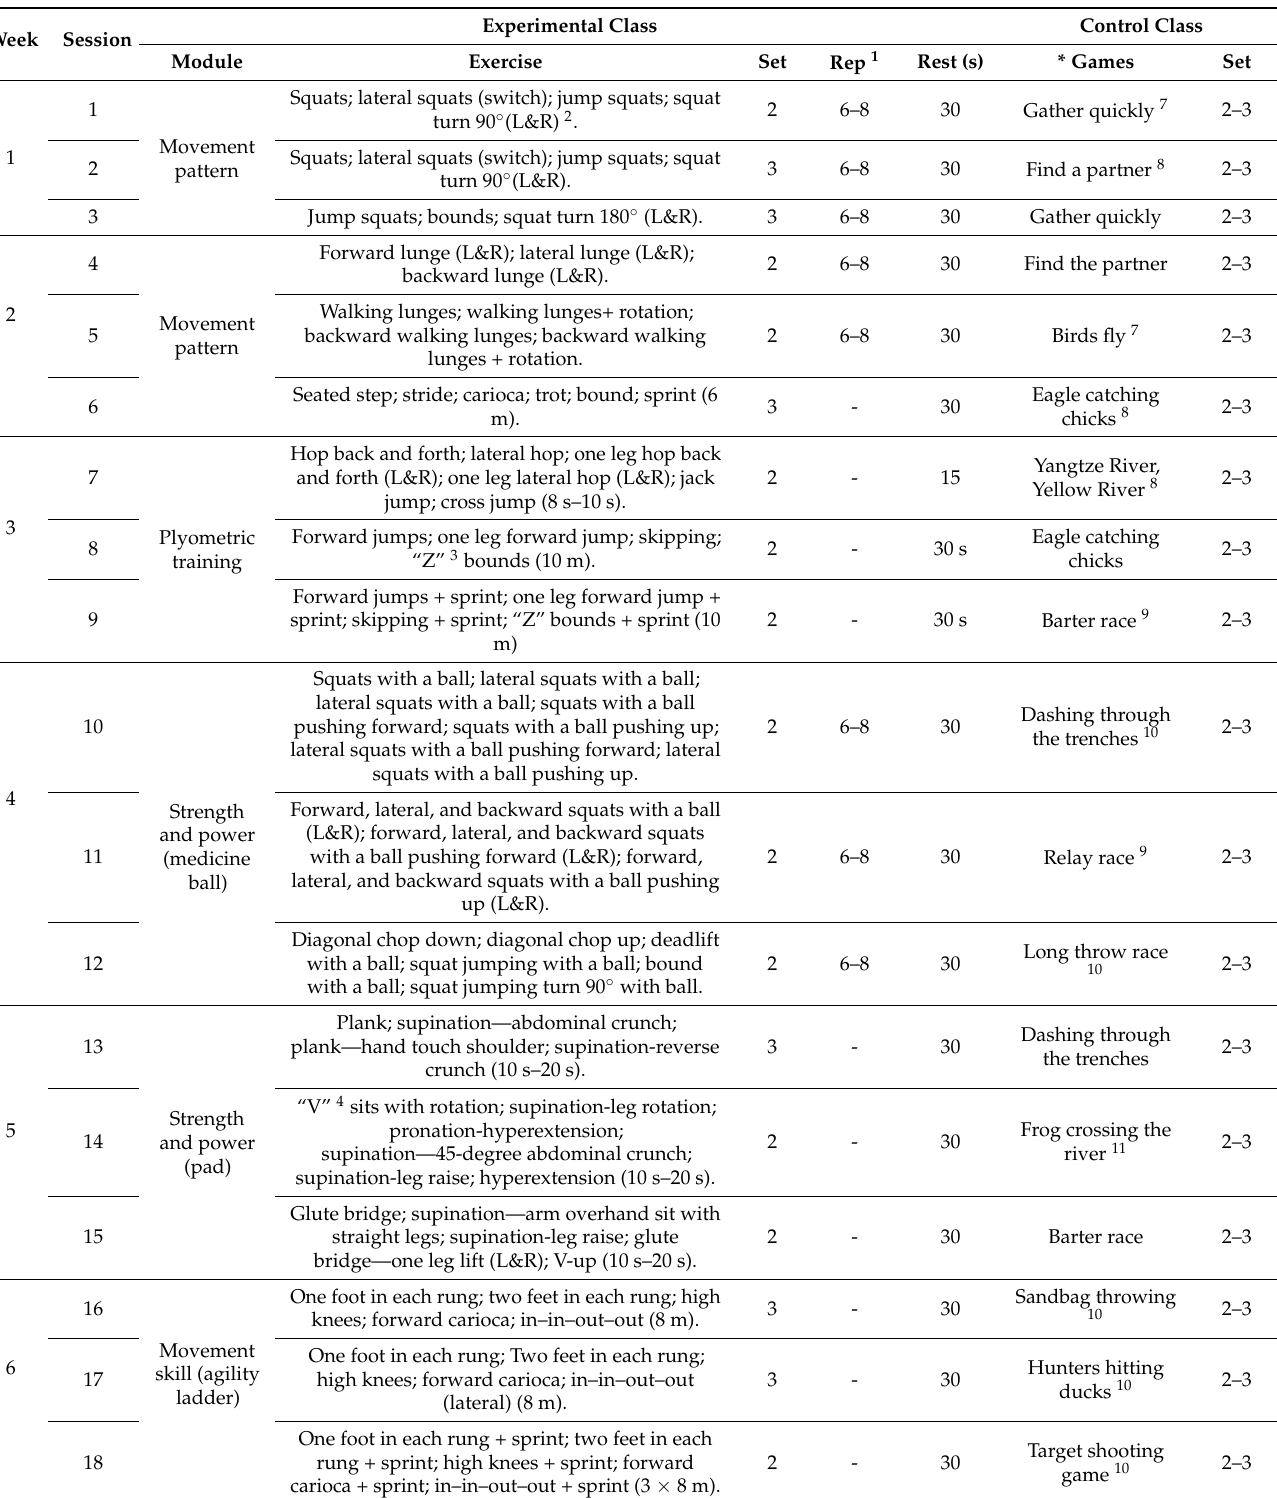
Table 1. Details of a 10-min physical fitness intervention for the experimental class and examples of corresponding activities of the control